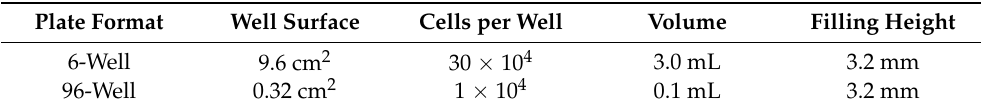
Table 1. Cell number, well volume and well filling height for different plate formats according to the respective size of the well